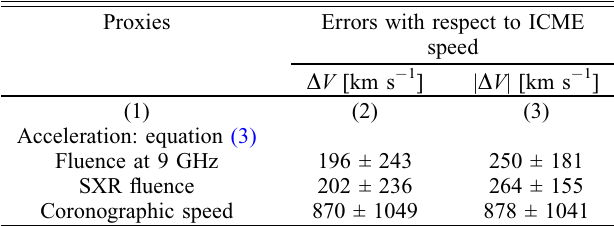
Table 5. ICME speeds at 1 AU: (col. 1) proxy used to infer the ICME speed, (col. 2) mean error value and its standard deviation, and (col. 3) mean absolute error value and its standard